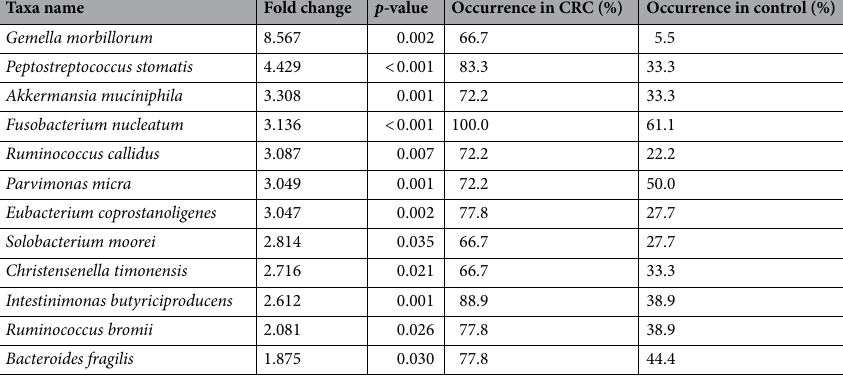
Table 3. Top 12 bacterial species over-represented in CRC compared to